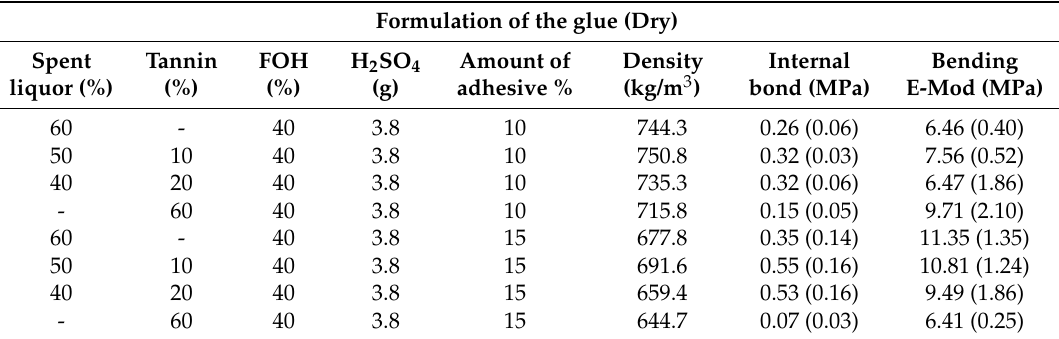
Figure 9. Density profile of the particleboards with spent-liquor/FA (10% and 15%) and tannin/FA (10% and 15%). Table 5. Mechanical performances of the SL/FA and T/FA particleboard test. Formulation of the glue